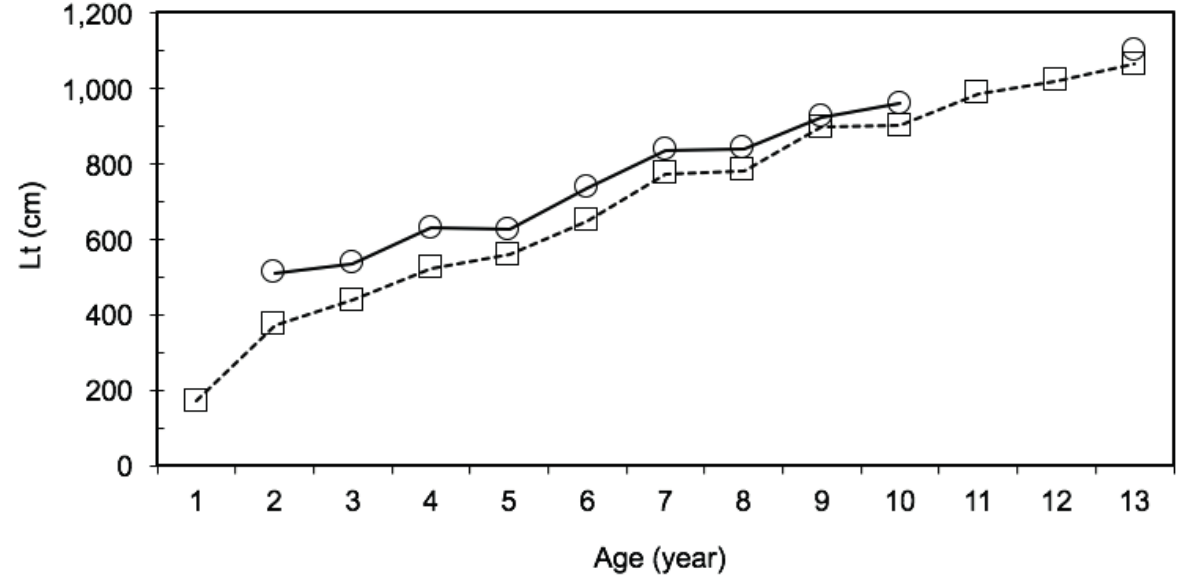
Figure 3 - Average back calculated (BPH) and observed lengths (Lt) by age class of the pink cusk-eel Genypterus brasiliensis